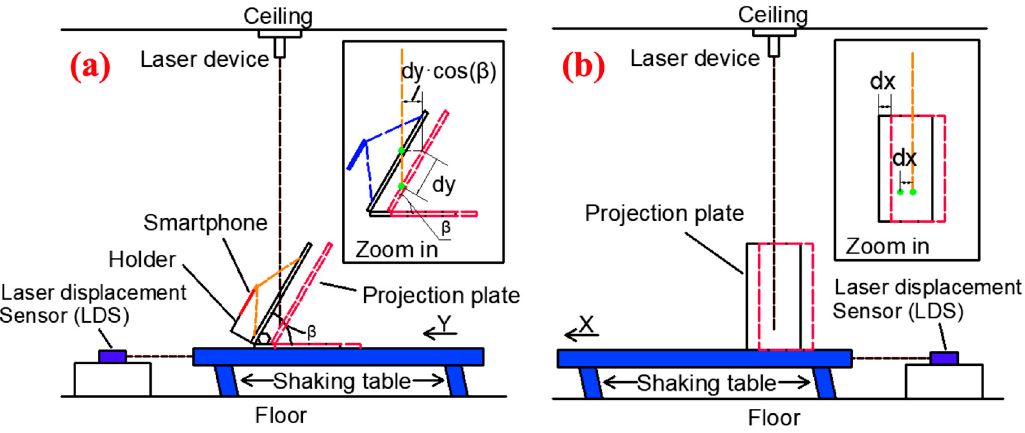
Figure 3. A schematic diagram of the experiment: ( a ) The elevation view (vibration direction along Y-axis); ( b ) The side view (vibration direction along X-axis).